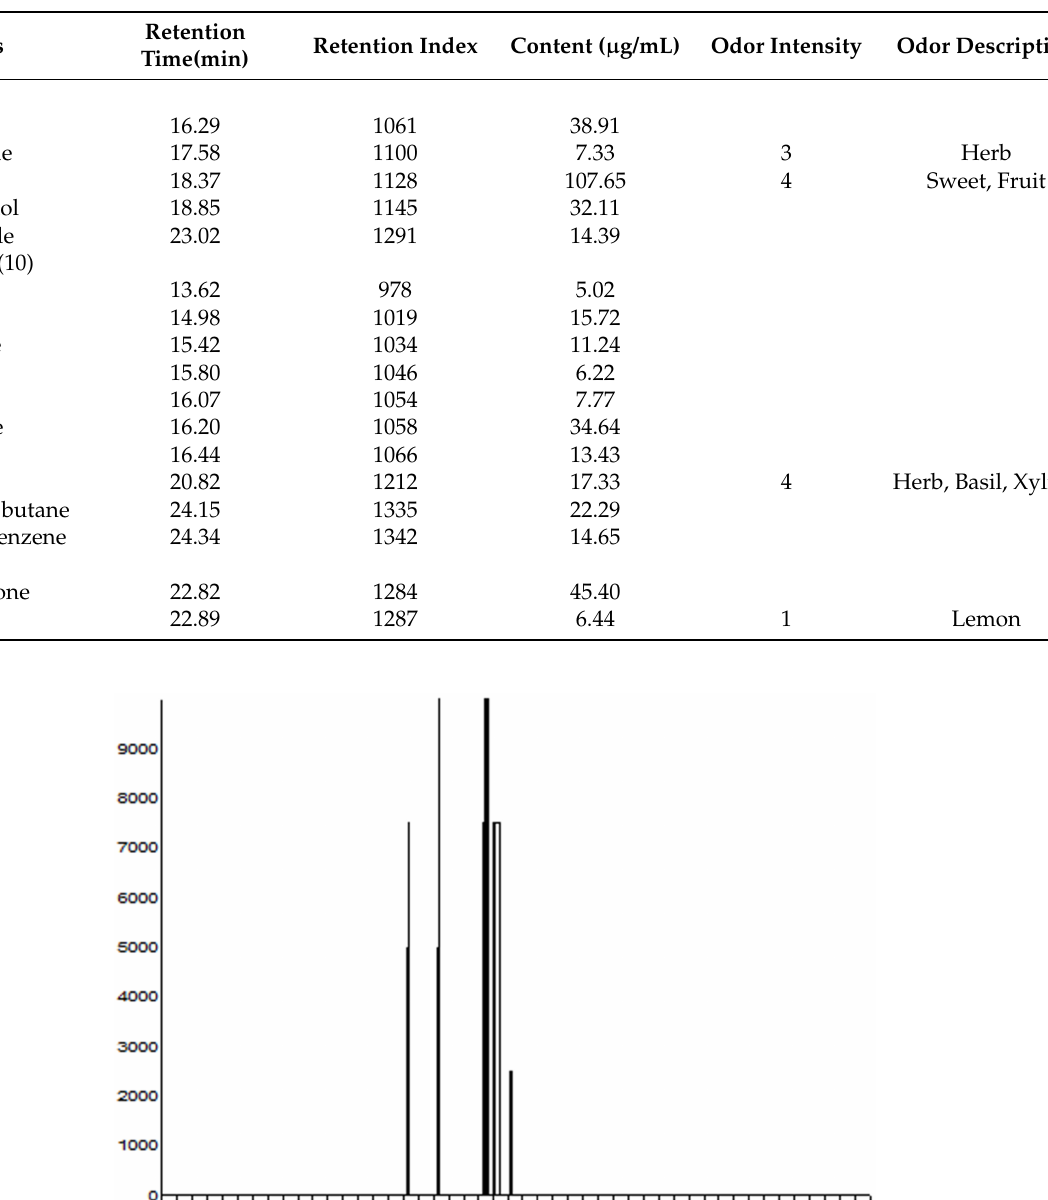
Table 1. Aroma profiles and odor-active aroma compounds in basil essential oil identified using GC–MS and GC–O.